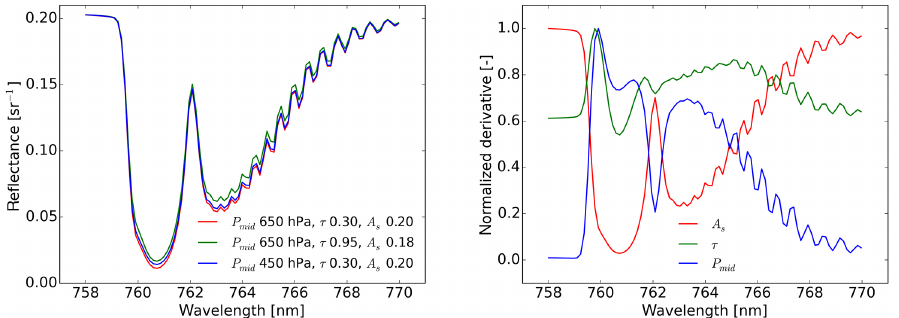
Figure 1. Left panel: simulated top-of-atmosphere reflectance spectra for three different aerosol scenarios at a resolution of 0.38nm. The solar zenith angle is 50 ◦ and the viewing direction is nadir. The spectrum plotted in red corresponds to the example scenario of an aerosol layer between 700 and 600hPa with an optical thickness at 760nm of 0.3 over a ground surface with albedo of 0.2. The spectrum plotted in green corresponds to the scenario of an aerosol layer with the same height and pressure thickness but with a different optical thickness and for a surface with a different albedo such that the continuum reflectance remains the same. For comparison, the spectrum plotted in blue corresponds to the scenario of an aerosol layer moved to a different height but with optical thickness and surface albedo the same as in the example scenario. Signal-to-noise ratios for these reflectance levels expected for TROPOMI are about 1000 in the continuum to about 250 in the deepest part of the absorption band. Right panel: derivatives of reflectance with respect to surface albedo, aerosol optical thickness and aerosol layer mid pressure for the example aerosol scenario. Derivatives are normalised to 1.0 at their respective maximums. Both panels: the aerosol has a single scattering albedo of 0.95 and a Henyey–Greenstein phase function with an asymmetry parameter of 0.7. The forward model for these calculations is the same as the forward model used in the GOME-2A retrievals. For simplicity, we assume the surface albedo to be independent of wavelength. Furthermore, the temperature profile corresponds to a mid-latitude summer atmosphere and the surface pressure is 1013hPa.